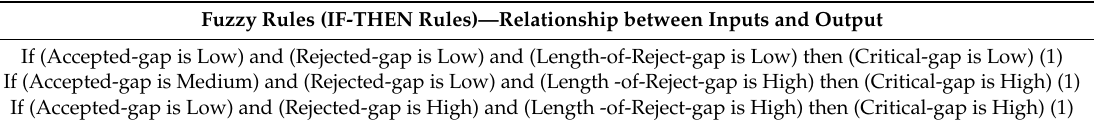
Table 2. A few examples of IF-THEN rules that have been used as part of the proposed fuzzy decision. Fuzzy Rules (IF-THEN Rules)—Relationship between Inputs and Output